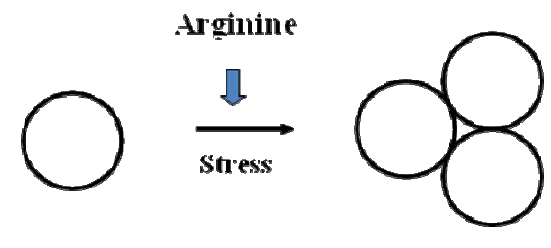
Figure 4. Virus inactivation mechanism-2: arginine in the presence of other stresses causes aggregation or dissociation of virus particles depending on their initial physical